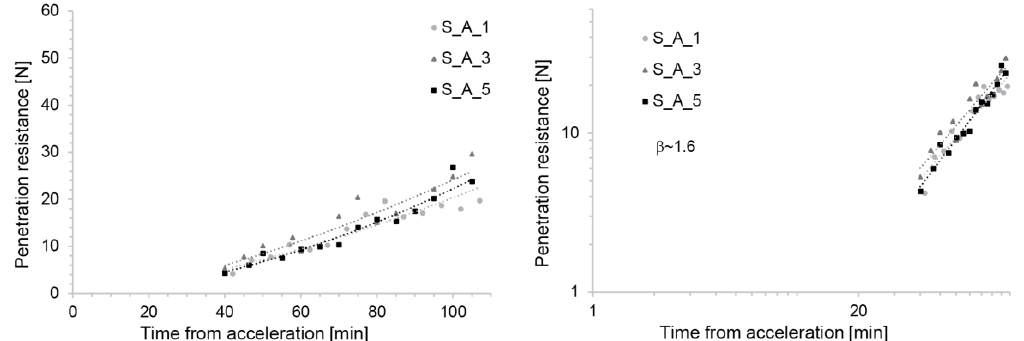
Figure 5. Strength evolution of the S_A Mix with aluminium sulfate solution as accelerator and simultaneous superplasticizer addition of an increased amount over time. (Left) lin-lin scale. (Right) log-log scale. The straight line obtained on the log-log scale highlights the fact that the yield stress evolution can well be fitted by a power-law (see Equation (3)).